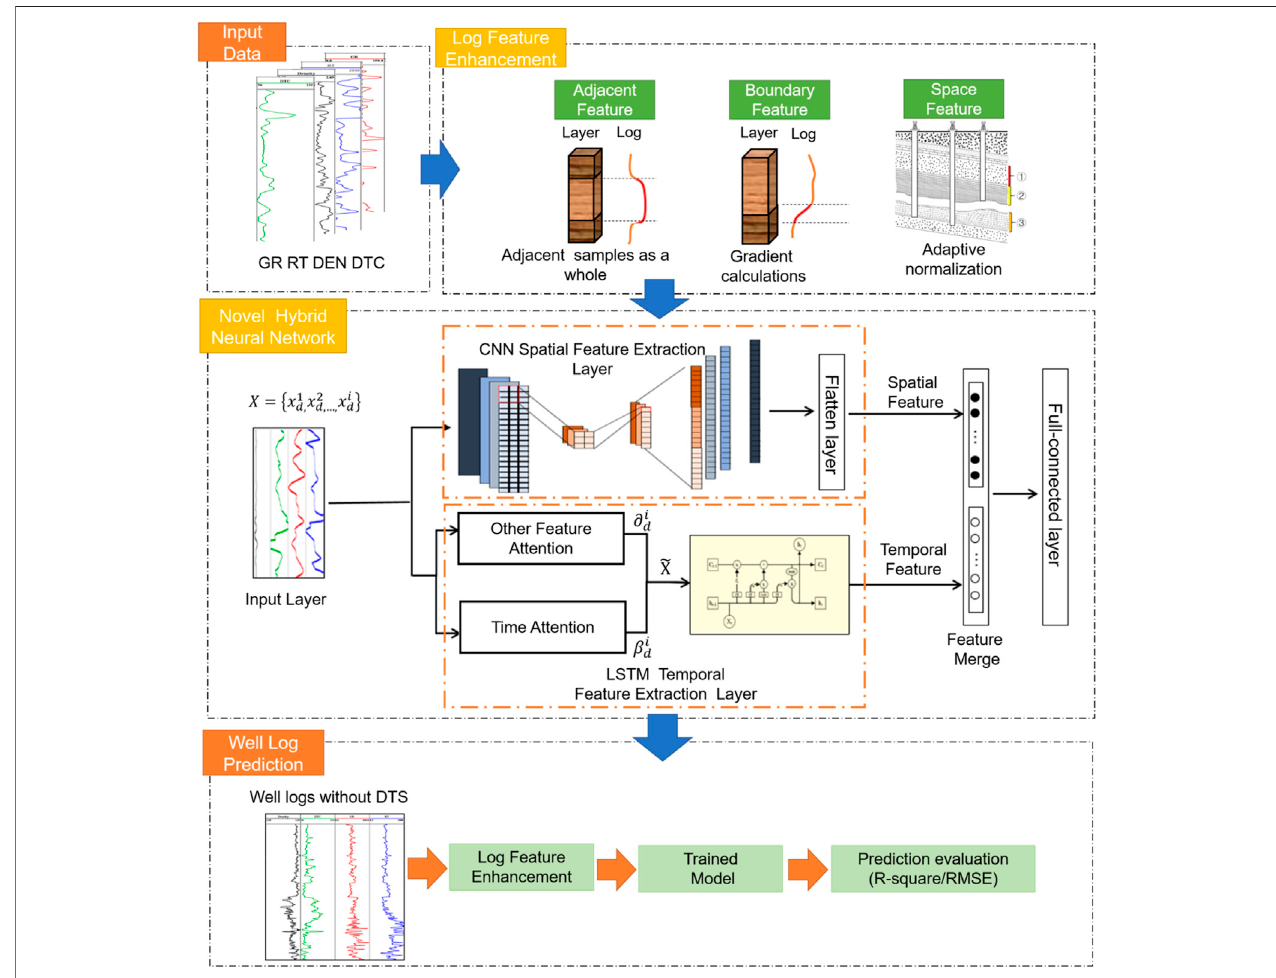
FIGURE 2 | Work fl ow for acoustic prediction using the proposed hybrid feature enhancement